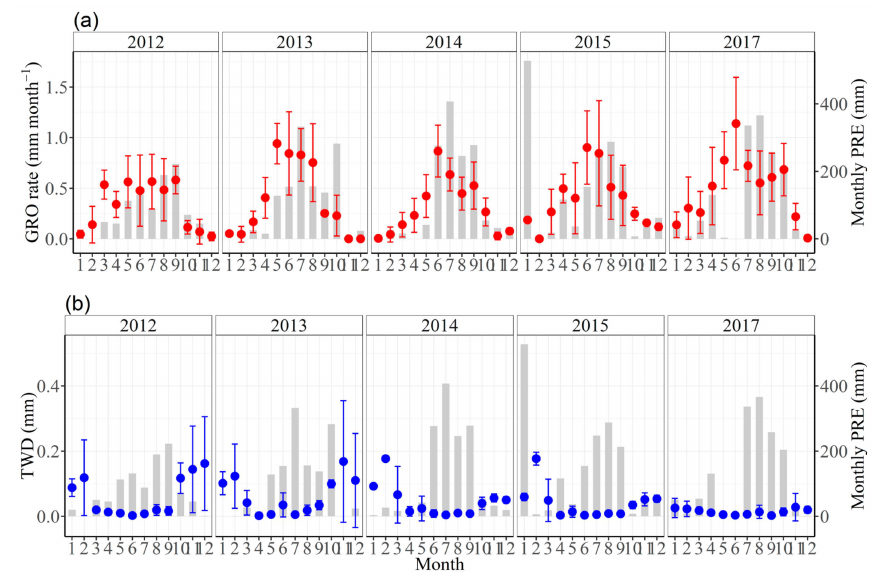
Figure 4. Comparison between monthly sums of precipitation (mm, gray bars) and ( a ) monthly sums of daily growth-induced irreversible stem expansion (GRO rate, mm · month − 1 , red points), and ( b ) monthly means of daily minimum tree water deficit (TWD, mm, blue points). Standard deviations of three individuals are also shown.